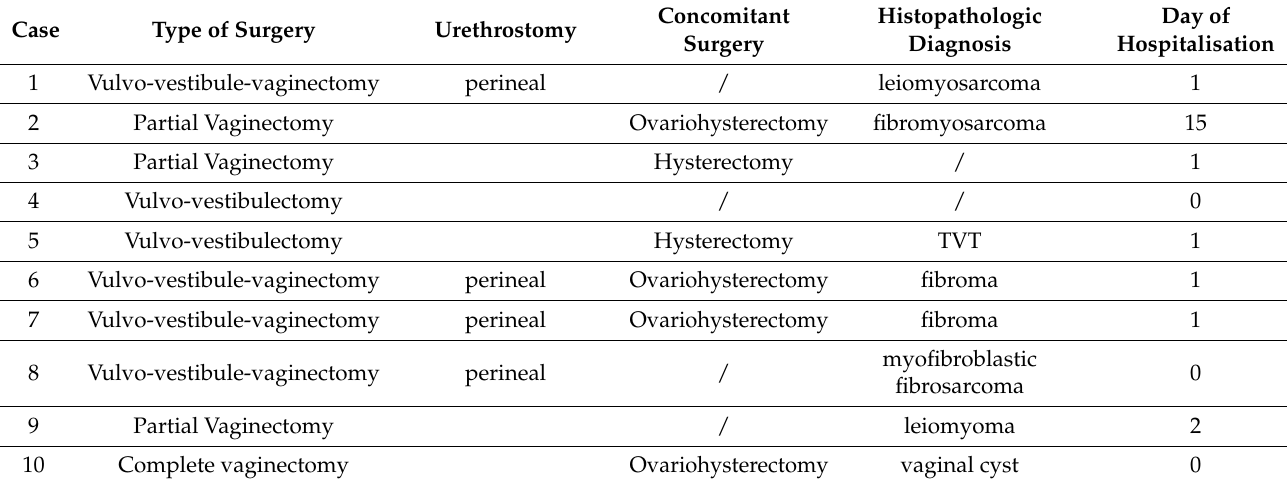
Table 3. Type of surgery and histopathological